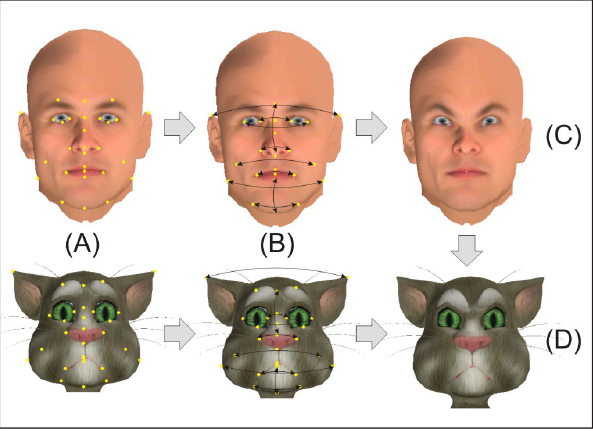
Figure 1. (A) Landmarks of the human model. (B) Base model measures. (C) Generation of expression and storage of proportions of the base model. (D) Expression applied to the second model, using the proportions of the base